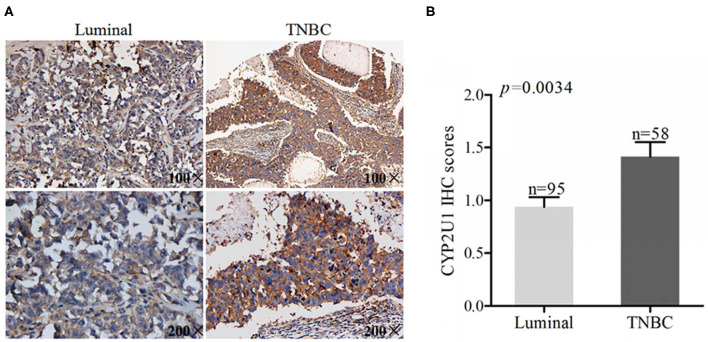
CYP2U1 is associated with molecular subtypes of breast cancer. (A) Representative images of IHC staining for luminal-type and TNBC breast cancer tissues were showed. (B) IHC scores revealed that higher level of CYP2U1 protein was significantly enhanced in TNBC tissues in comparison with luminal-type tissues, which was displayed as mean + SEM.